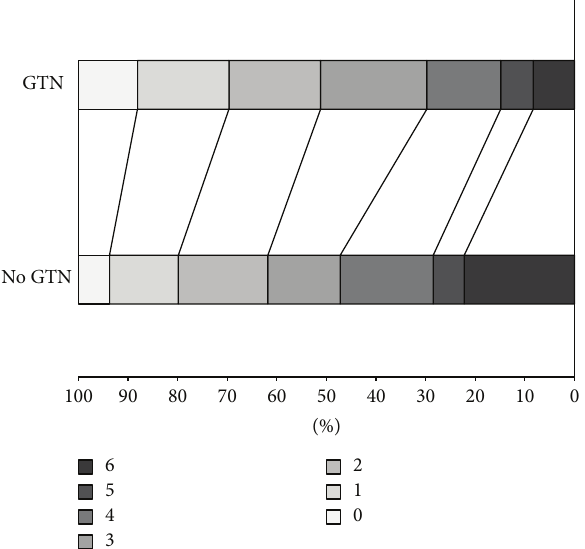
Figure 3: Distribution in modified Rankin scale scores at day 90 for glyceryl trinitrate versus no glyceryl trinitrate in 312 patients with any stroke and randomised within 6 hours of stroke onset. Common odds ratio 0.52 (95% confidence intervals 0.34–0.78; 𝑝 = 0.002